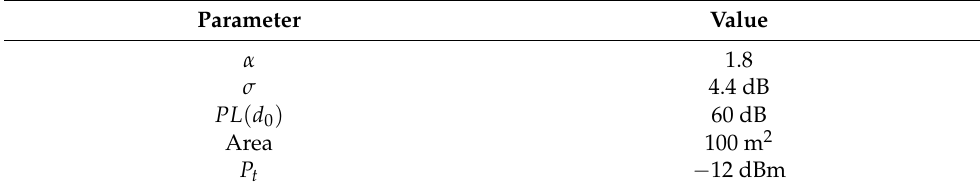
Table 1. Environment